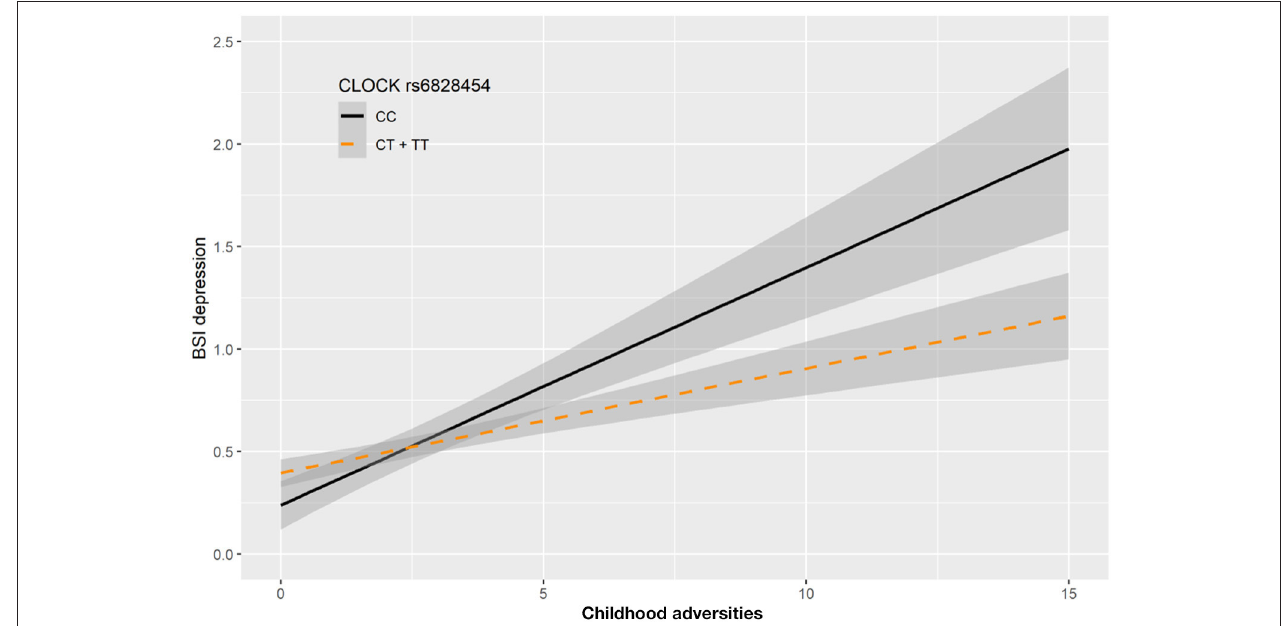
FIGURE 4 | Linear regression indicated a significant interaction between top SNP rs6828454 of a clump containing 9 SNPs in the CLOCK gene and exposure to childhood adversities on current depression symptoms (BSI-dep) in the recessive model, with the minor C allele being a risk allele. Linear regression indicated a significant interaction between CLOCK rs6828454 genotype and childhood adverse life events (CHA) on current depression scores according to the recessive model as top SNP ( p = 0.0006, FDR Q = 0.0118). Homozygous presence of the minor C allele was associated with higher depression scores in subjects exposed to more severe childhood adverse events conveying a risk effect. On the vertical axis weighted depression (BSI-Dep) scores are shown. The horizontal axis shows childhood adverse life events (CHA) as measured by an instrument derived from the CTQ ( 30). BSI-Brief symptom inventory. Gray shading denotes 95%CI.